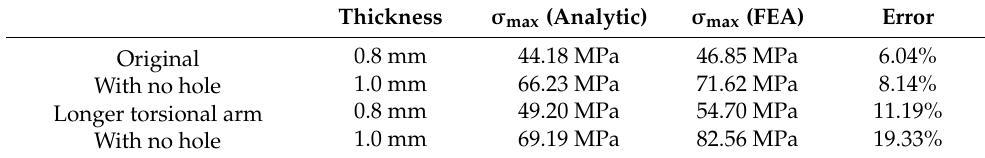
Table 4. Comparison of maximum normal stresses of tubular specimens subjected to combined loading.